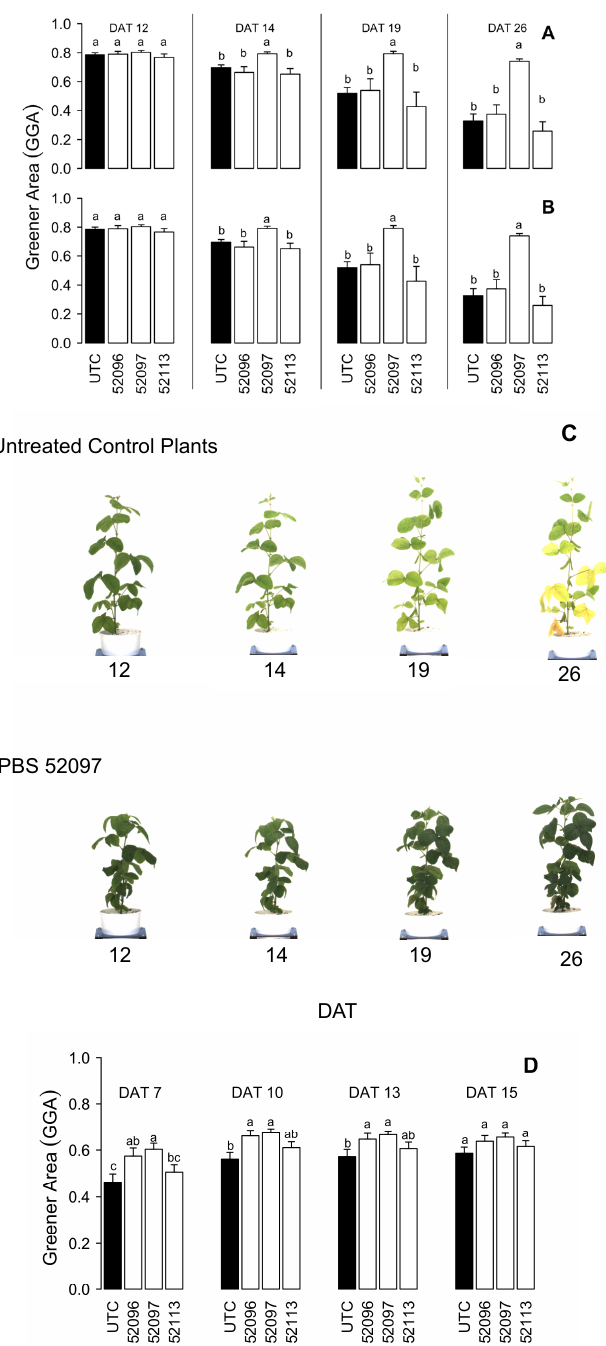
Figure 2. Mean values ± SE ( n = 5) of greener area (GGA) measured on ( A ) soybean plants treated with biostimulants at lower dosage, ( B ) soybean plants treated with biostimulants at higher dosage at 12, 14, 19, and 26 days after treatment (DAT). ( C ) Acquired RGB images of representative UTC (top) and 52097-treated (bottom) soybean plants, showing the effect of PBS application on color and growth during the trial (from T0 to 26 days after treatment). ( D ) GGA measurements taken on corn plants at 7, 10, 13, and 15 days after treatment (DAT). Solid black bars identify the untreated control plants (UTC).